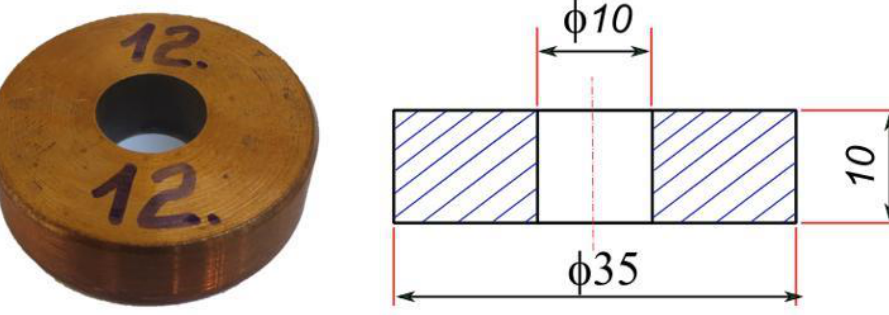
Figure 2. The 90CrSi alloy steel workpiece